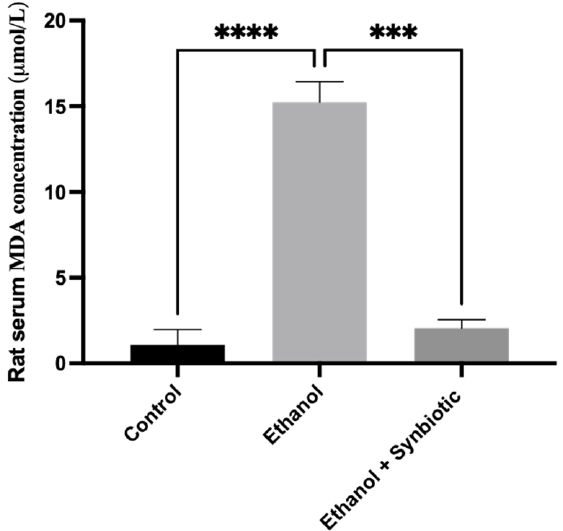
Figure 10. The HPLC technique determined the concentration of MDA in rat serum samples. The effect of the synbiotic (AGE + Lactobacillus rhamnosus ) on gut dysbiosis is investigated in the presence of ethanol. Results reveal that synbiotic preventive therapy is more beneficial in treating ALD. The statistical analysis was calculated as mentioned in Section 2.10, *** p < 0.001, **** p < 0.0001.